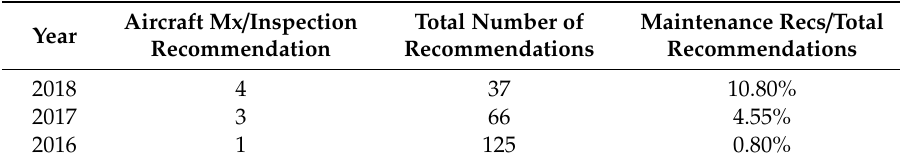
Table 1. UK Air Accidents Investigation Branch (AAIB) maintenance- and inspection-related safety recommendations, adapted from AAIB